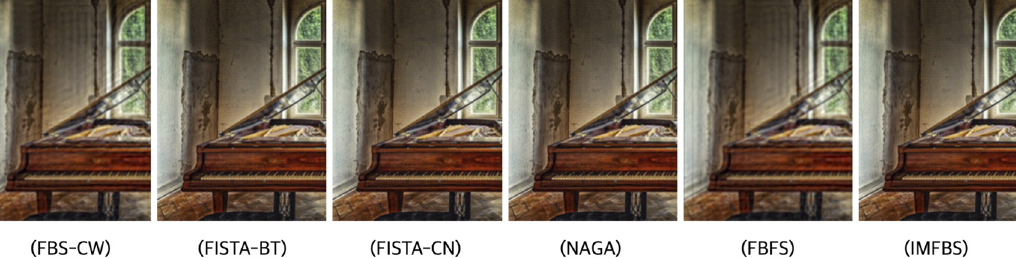
Figure 3: The restored images by BM - 1.1 for FBS - CW ( PSNR:26.07923, SSIM:0.7923 ) , FISTA - BT ( PSNR:38.9664, SSIM:0.9664 ) , FISTA - CN ( PSNR:39.2981, SSIM:0.9726 ) , NAGA ( PSNR:38.8771 SSIM:0.9708 ) , FBFS ( PSNR:24.8915 SSIM:0.7331 ) , and IMFBS ( PSNR:41.7181, SSIM:0.9828 ) , respectively.